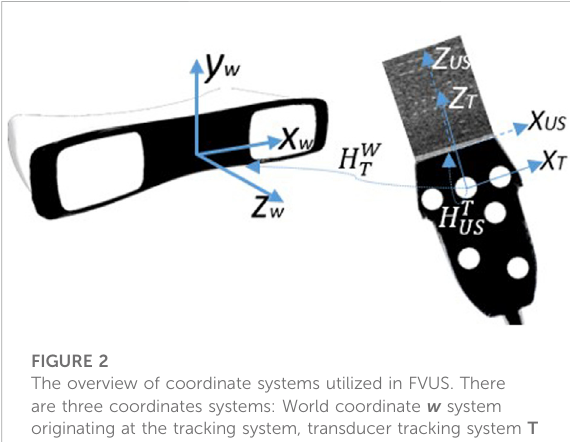
FIGURE 2 The overview of coordinate systems utilized in FVUS. There are three coordinates systems: World coordinate w system originating at the tracking system, transducer tracking system T originating at one of the optical markers, and ultrasound coordinate system US originating at the middle of the transducer